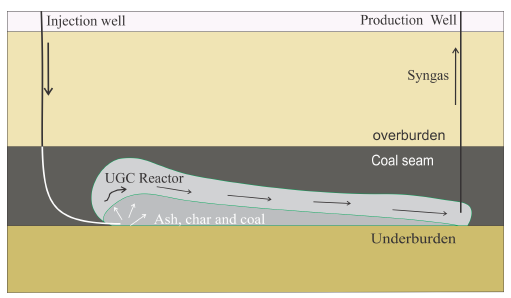
Figure 1. Linked Vertical Well Method (Modified after Shirsat, 1989).